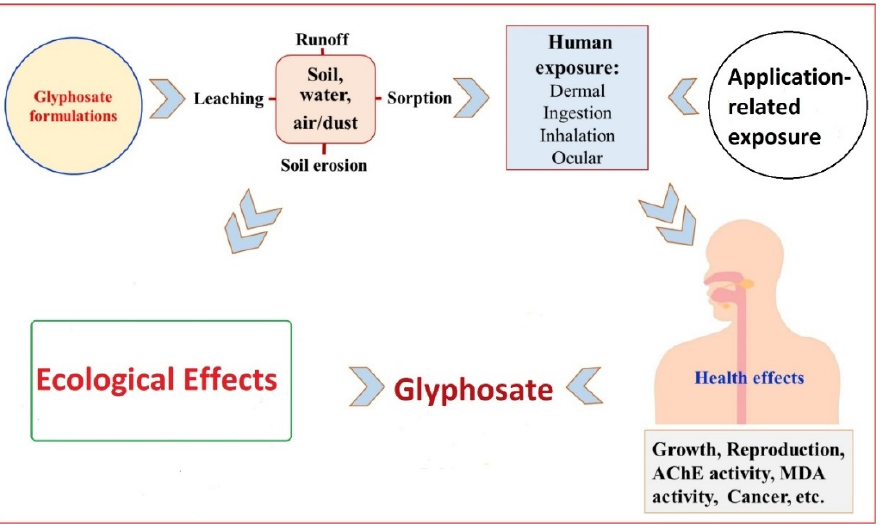
Figure 2. Pathways of glyphosate-based formulations in human health and the environment [148].